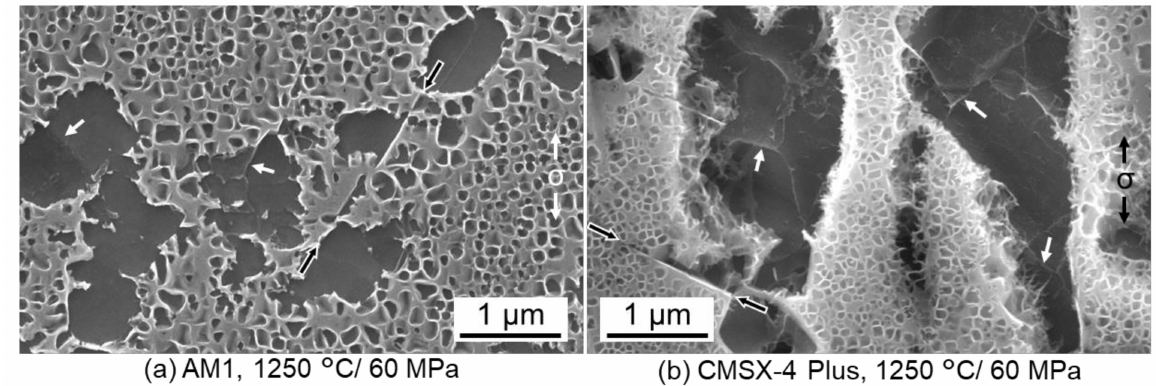
Figure 9. Near the fracture surface of AM1 ( a ) and CMSX-4 Plus ( b ) after creep rupture tests at 1250 ◦ C/60 MPa. White arrows are pointing at grain boundaries in γ (cid:48) phase. Black arrows are indicating shearing